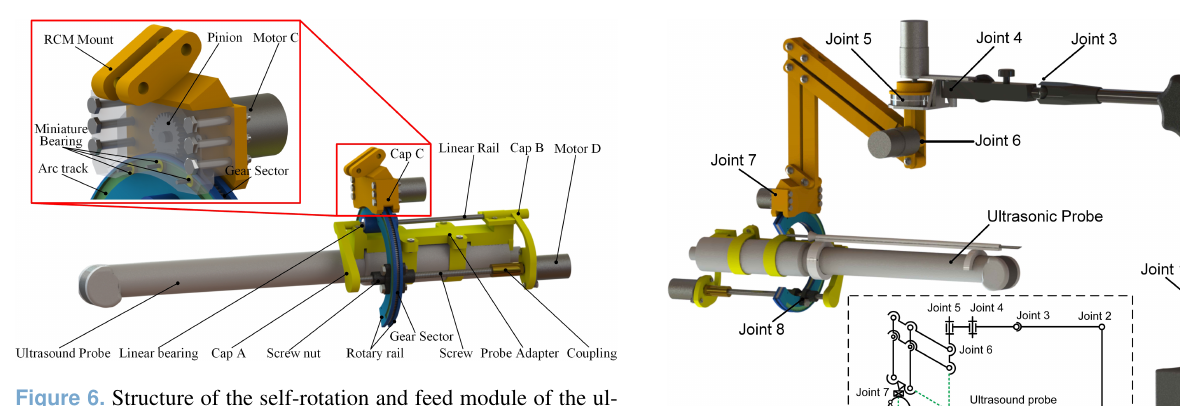
Figure 6. Structure of the self-rotation and feed module of the ul- trasound probe.